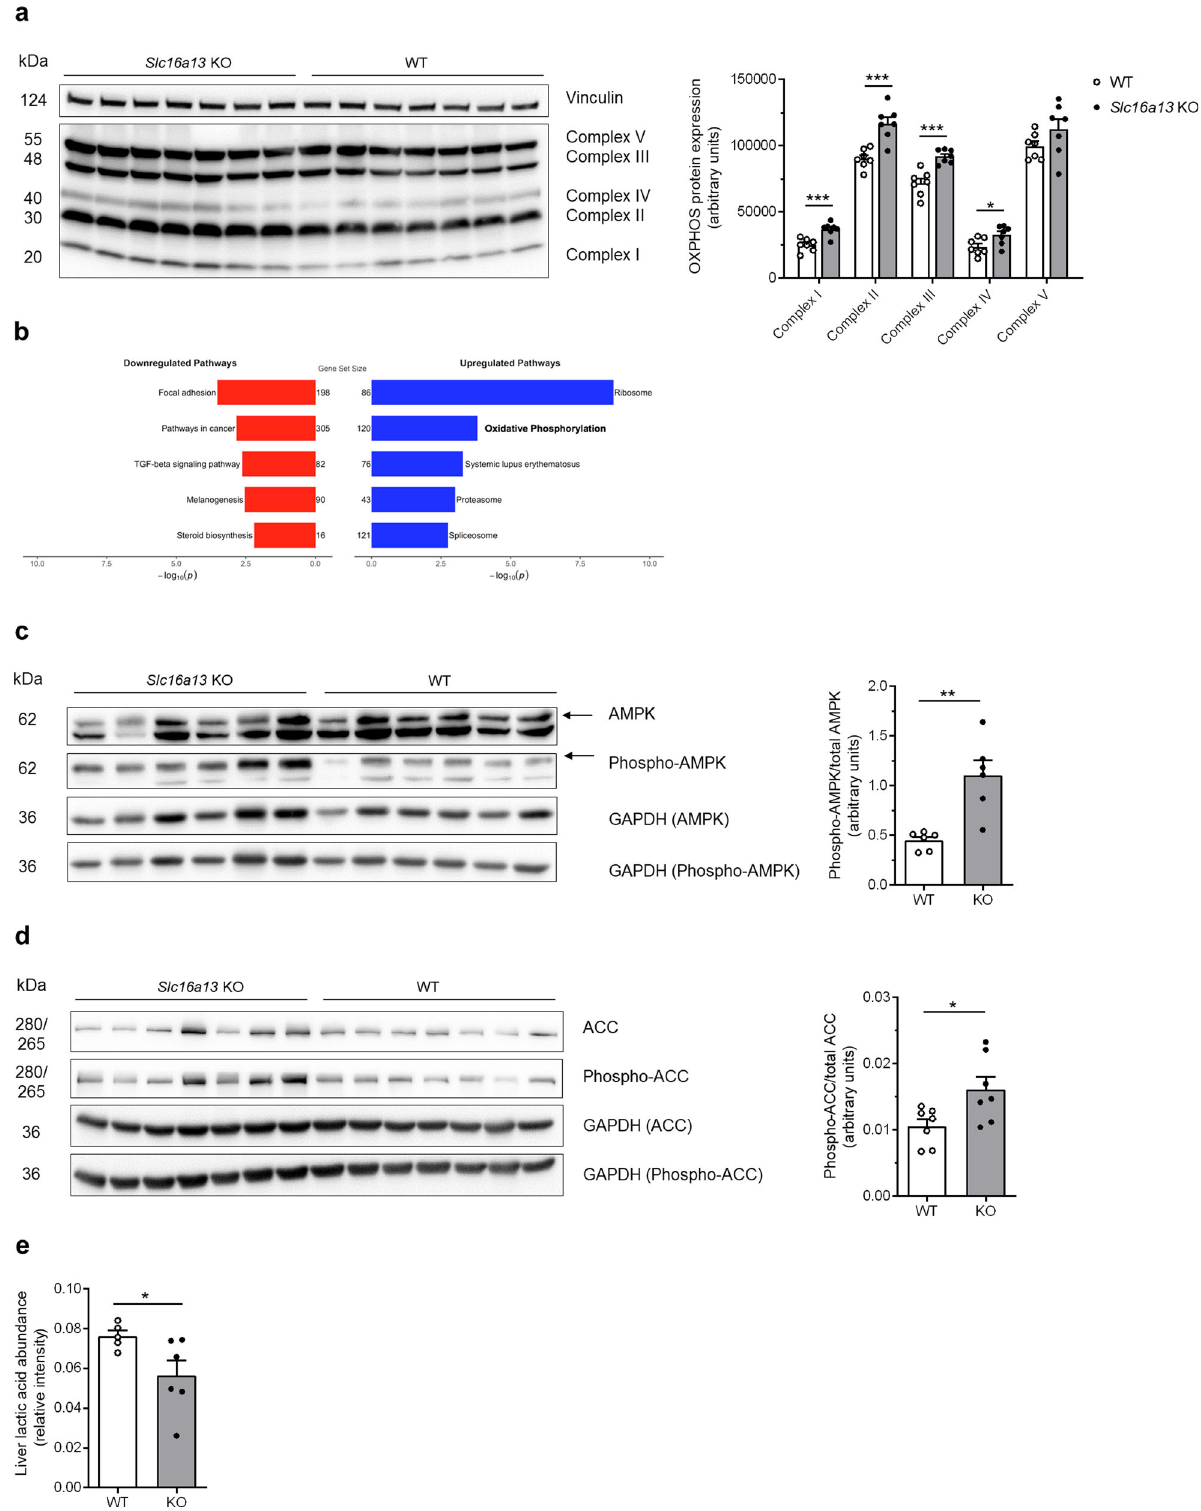
Fig. 9 Molecular insight into increased mitochondrial respiration in Slc16a13 knockout mice at 15 weeks of HFD. a Hepatic protein expression of respiratory chain complexes I – V determined by western blot. b Gene set enrichment analysis of liver transcriptomic data from WT and Slc16a13 KO mice. c AMPK phosphorylation as a ratio of phospho-AMPK/total AMPK determined by western blot. d ACC phosphorylation as ratio of phospho-ACC/total ACC determined by western blot. Slc16a13 WT ( n = 6 – 7), Slc16a13 KO ( n = 6 – 7). e Relative lactic acid levels determined by untargeted metabolomics in the livers of WT ( n = 5) and Slc16a13 KO mice ( n = 6). a , c – e Bars represent means ± SEM. * p < 0.05, ** p < 0.01, *** p < 0.001 determined using two-tailed unpaired Student ’ s t -test, Welch correction for unequal variance was used in e